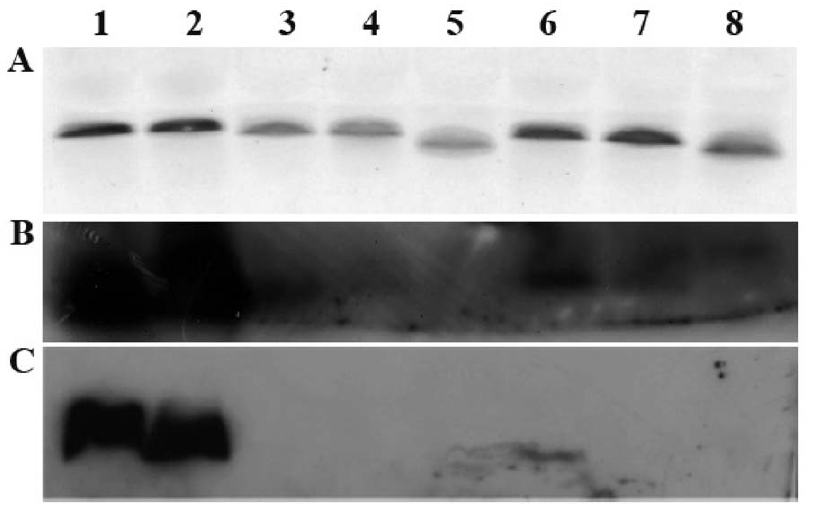
Figure 2. Silver stain (A), CTB blot (B) and PNA blot (C) of resolved LOS from C.jejuni isolates. Lane 1: C. jejuni 11168-O, lane 2 : C. jejuni 224, lane 3: C. jejuni 331, lane 4: C. jejuni 421, lane 5: C. jejuni 351, lane 6: C. jejuni 375, lane 7: C. jejuni 520, lane 8: C. jejuni 81–176.